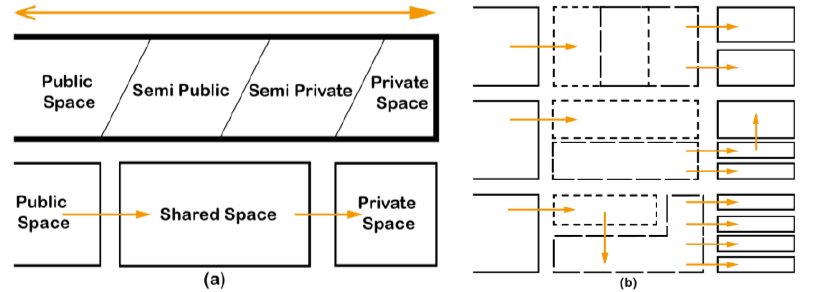
Figure 19. ( a ) Characteristic of Territory Quality Analysis. ( b ) Transformation Relationship Form of Public Space to Private Space.